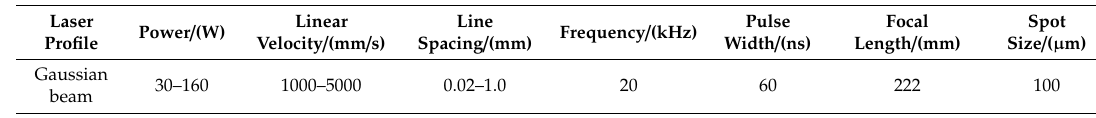
Table 2. The laser process parameters.